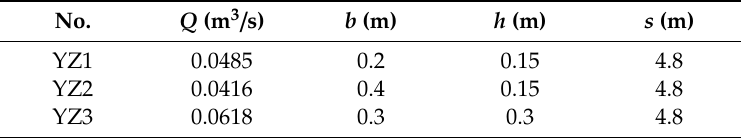
Table 2. Simulation conditions of cases.